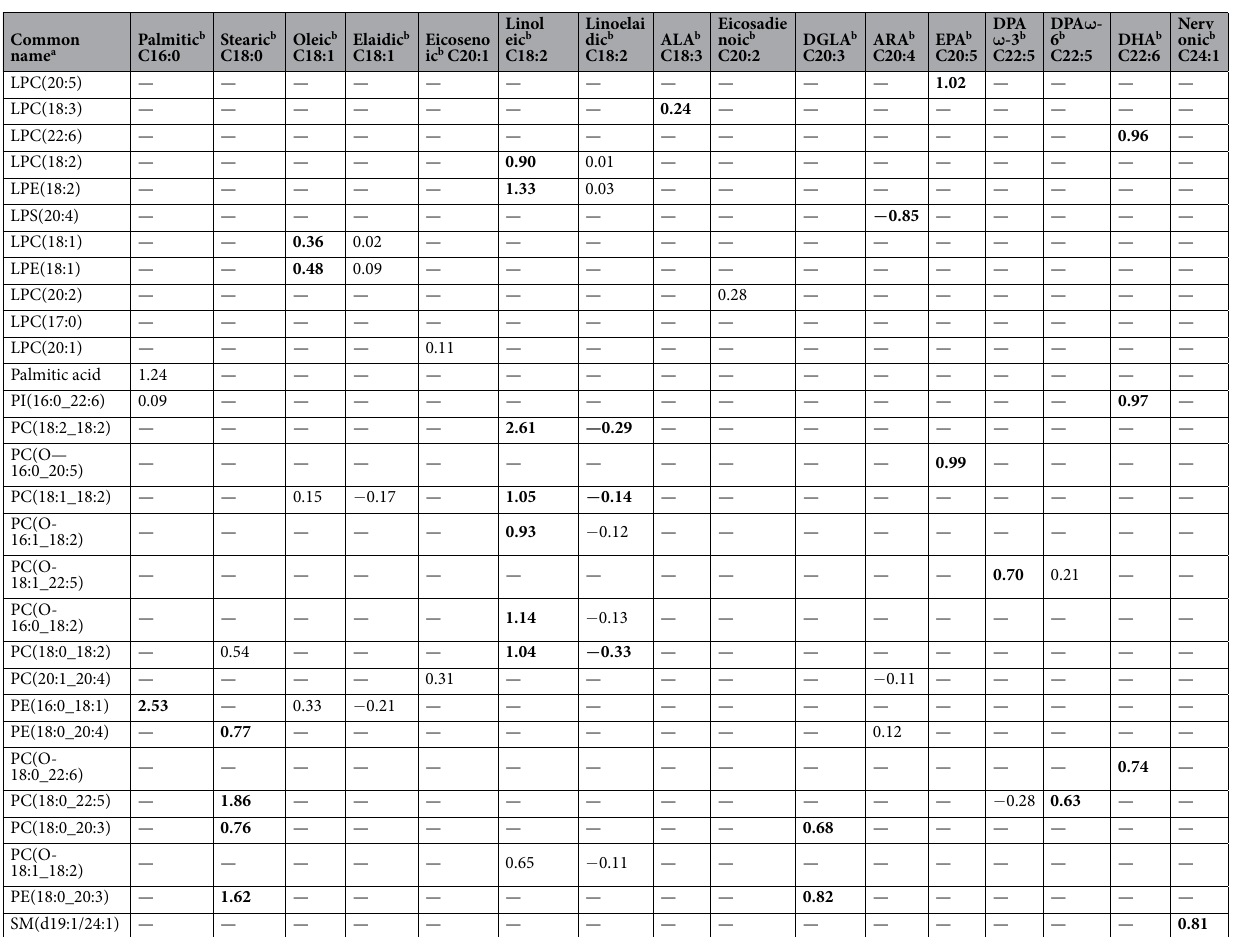
— 0.12 — — — 0.74 0.68 0.65 1.62 — — — — — — — 0.82 — — 0.81 Table 4. Relationship between untargeted PL FA chains and the % of geometric and positional FA isomers in plasma PL. Each plasma PL was regressed on the % of each FA isomer in the plasma PL, and models were adjusted for BMI. This was performed to determine the relationship between the abundance of each plasma PL significantly associated with the responses in our study and the % of FA isomers in plasma PL from our previous study. For instance, LPC(18:2) and LPE(18:2) were significantly associated with the % of linoleic acid (LA, ω -6, C18:2 Δ 9Z,12Z ) in plasma PL, whereas LPC(18:2) and LPE(18:2) were not correlated with the % of trans- isomer linoelaidic acid ( ω -6, C18:2 Δ 9E,12E ) in plasma PL. Numeric values represent the estimated effects (beta coefficients) and are bolded if p < 0.05. The plasma analyzed from both data sets were collected at the same time point from the same patients. Models were defined as: log(plasma PL) = log(% FA isomer in plasma PL) + BMI. a The significant PL associated with the responses that were structurally characterized in our study. The experimental methodology employed was the UPLC-ESI-MS E analysis of crude lipid extracts outlined in this manuscript. b The geometric and positional FA isomers that were targeted in our previous study (Pickens et al . PLEFA. 2015). The experimental methodology employed was the FAME analysis of isolated plasma PL by GC- FID. The specific isomers investigated were: oleic acid ( ω -9C18:1 Δ 9Z ), elaidic acid ( ω -9C18:1 Δ 9E ), eicosaenoic acid ( ω -9, C20:1 Δ 11Z ), linoleic acid (LA, ω -6, C18:2 Δ 9Z,12Z ), linoelaidic acid ( ω -6, C18:2 Δ 9E,12E ), dihomo-gamma- linolenic acid (DGLA, ω -6, C20:3 Δ 8Z,11Z,14Z) , arachidonic acid (ARA, ω -6, C20:4 Δ 5Z,8Z,11Z,14Z ), docosapentaenoic acid ω -6 (DPA ω -6, C22:5 Δ 4Z,7Z,10Z,13Z,16Z ), alpha-linolenic acid (ALA, ω -3, C18:3 Δ 9Z,12Z,15Z) , eicosapentaenoic acid (EPA, ω -3, C20:5 Δ 5Z,8Z,11Z,14Z,17Z ), docosapentaenoic acid ω -3 (DPA ω -3, C22:5 Δ 7Z,10Z,13Z,16Z,19Z ), docosahexaenoic acid (DHA, ω -3,C20:5 Δ 4Z,7Z,10Z,13Z,16Z,19Z ), and nervonic acid ( ω -9, C24:1 Δ 15Z